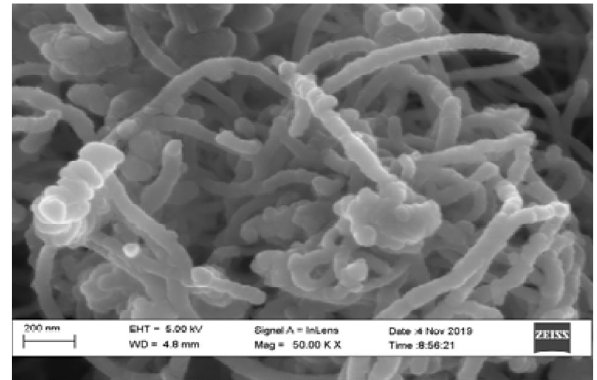
Figure 3. SEM micrographs of Ag/CO 3 O 4 /TiO 2 nanocomposite.